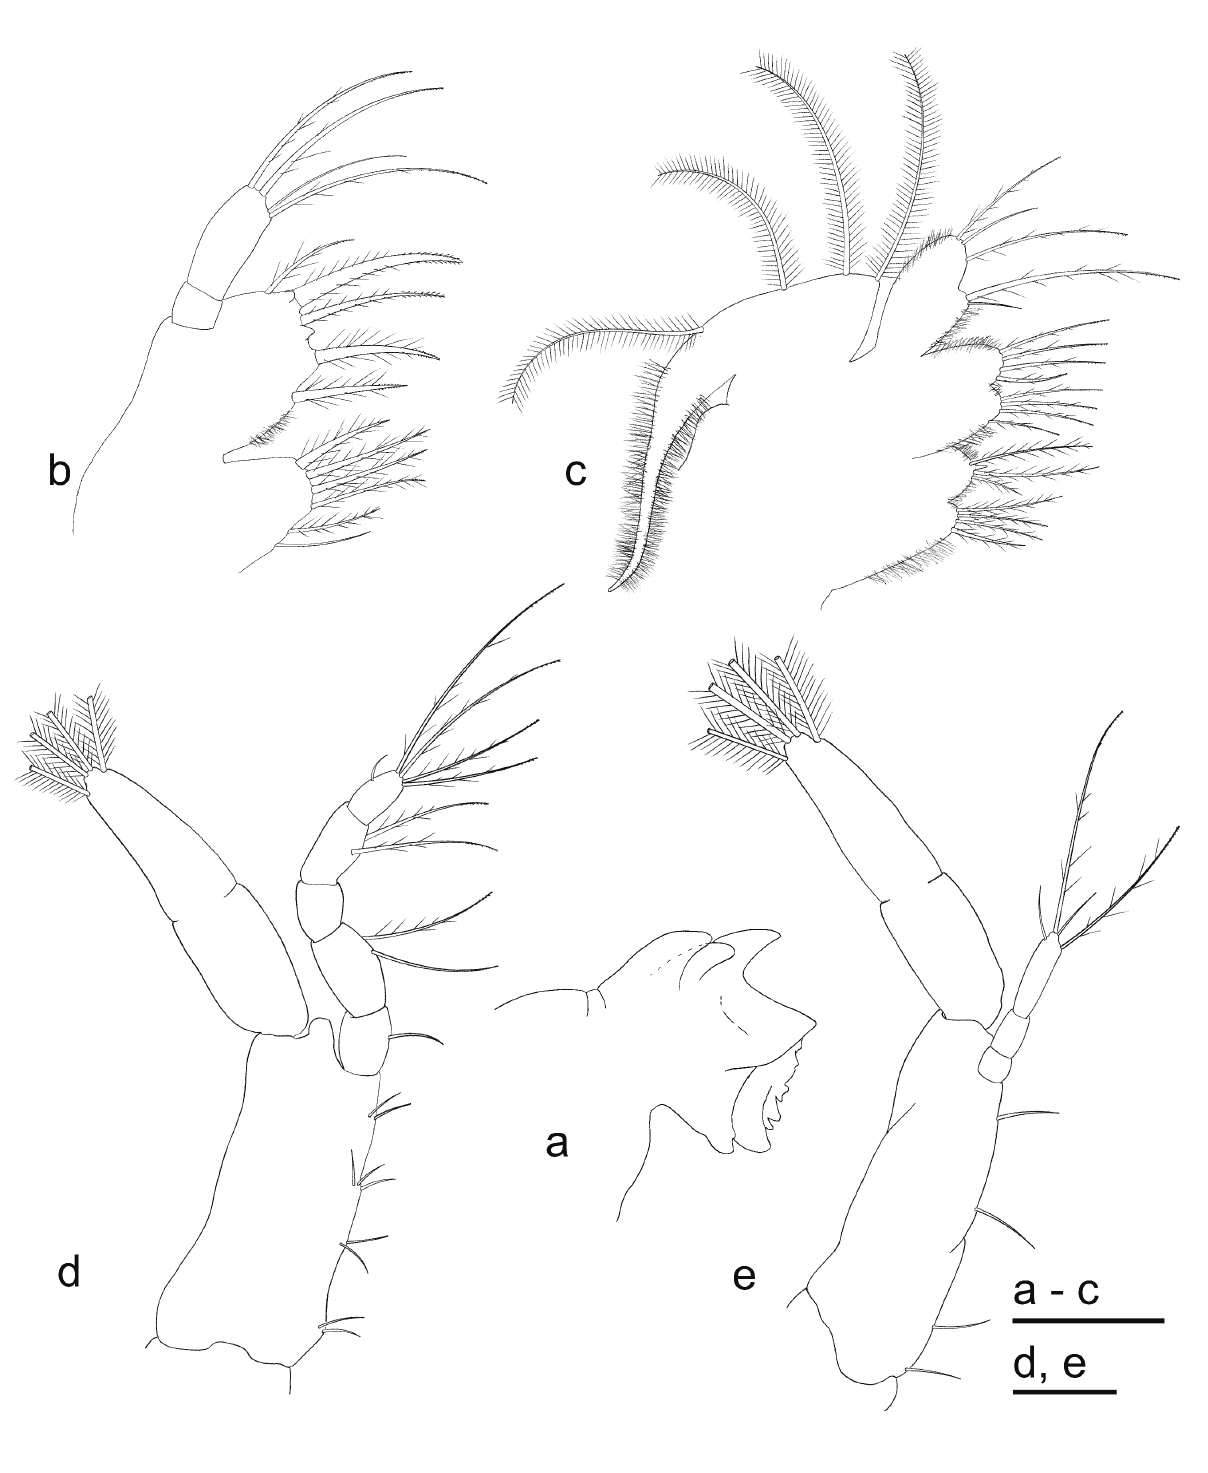
Figure 2. Domecia acanthophora (Desbonne, in Desbonne & Schramm, 1867), Zoea I. a. Mandible; b. Maxillule; c. Maxilla; d. First maxilliped; e. Second maxilliped (scale bars: a–e = 0.05